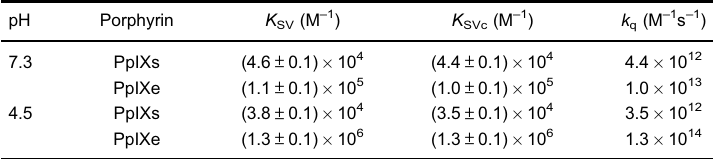
Figure 8. Fluorescence spectra of 8.5 m M bovine serum albumin (BSA) solutions ( l ex=280 nm) at pH 7.3 ( A , B ) and pH 4.5 ( C , D ) at different synthetic protoporphyrin IX (PpIXs) ( A , C ) and endogenous protoporphyrin IX PpIXe ( B , D ) concentrations. Insets are their fi ttings in accordance with equation 5. Table 4. The average values of determined ( K SV ) and corrected ( K SVc ) Stern- Volmer and bimolecular quenching ( k q ) constants of the BSA fl uorescence quenching by PpIXs and PpIXe at two